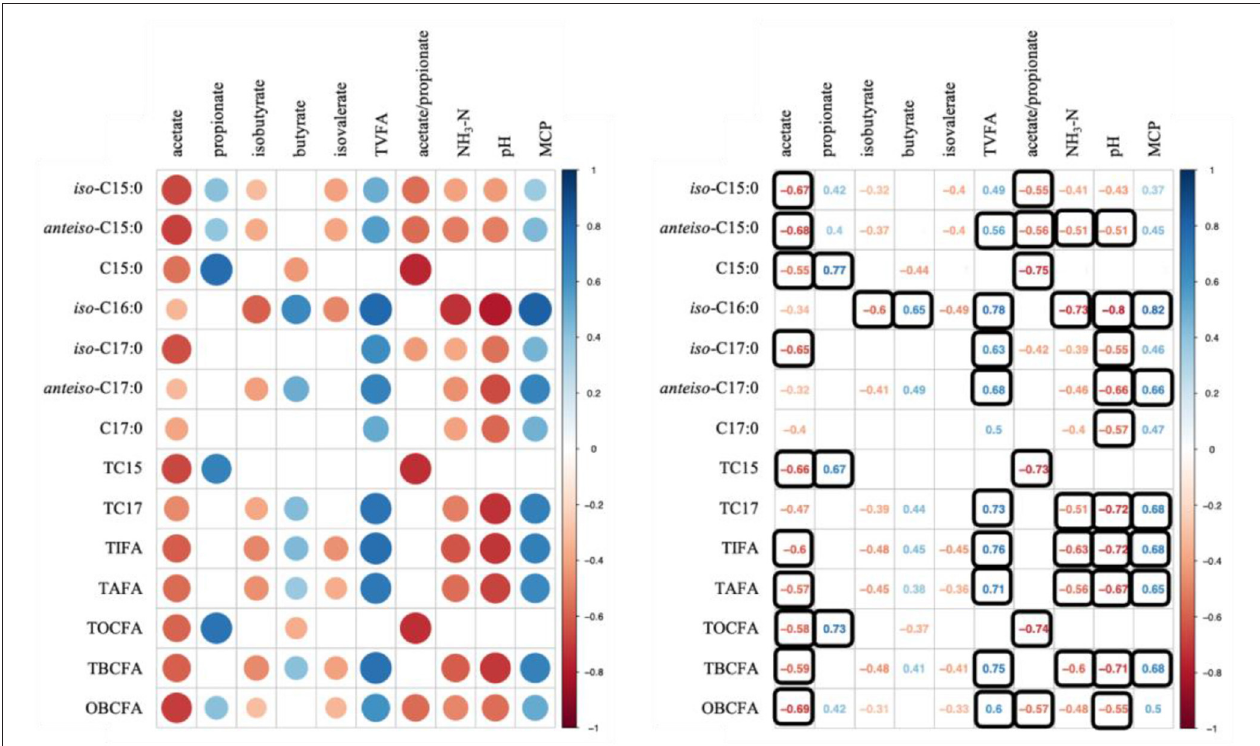
FIGURE 1 | Correlation analysis between ruminal fermentation parameters/MCP and OBCFA concentrations during 24h of incubation in vitro . Color in round shape represents significant correlations ( P < 0.05) and black square means − 0.50 > ρ >